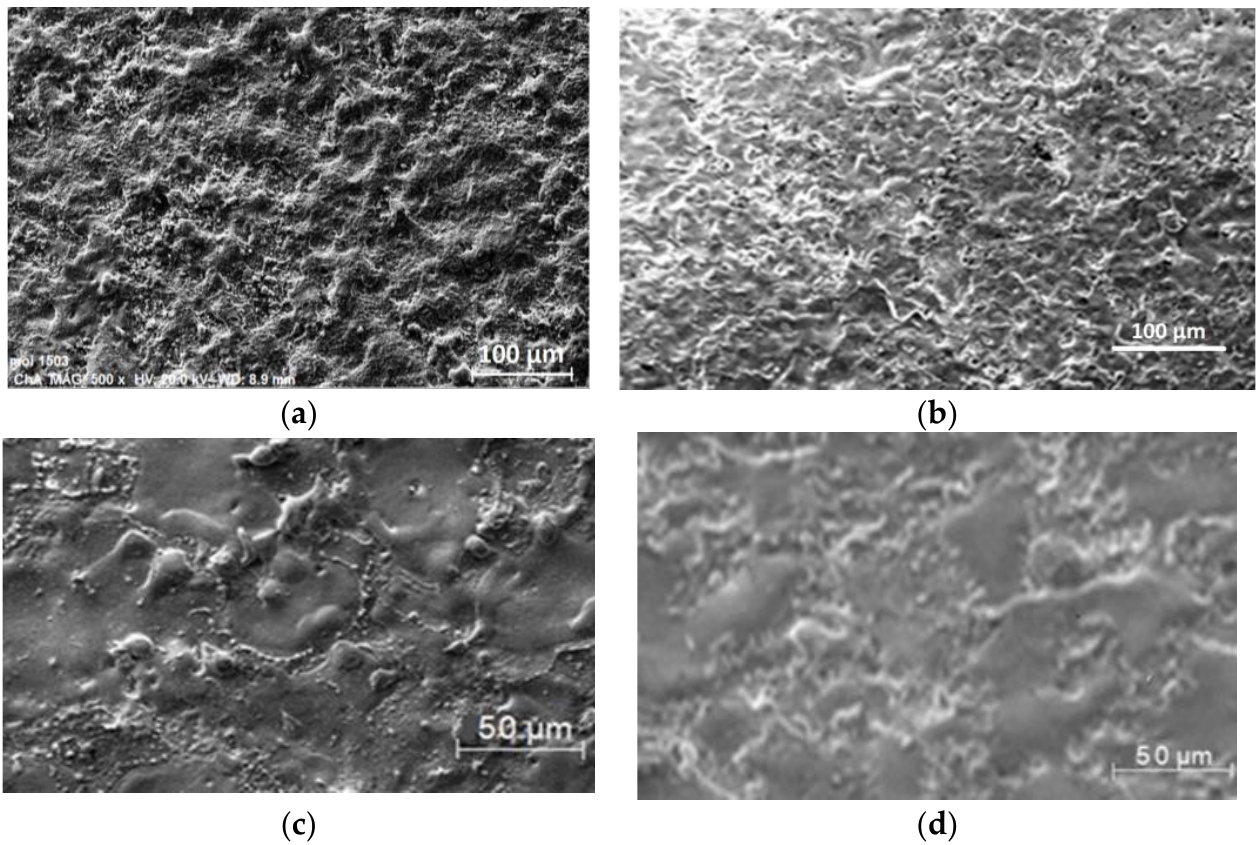
Figure 2. The SEM topography of ESD coated titanium (Ti6Al4V) surface with different electrodes. ( a ) ESD with KW10T10B10 electrode, E = 0.07 J; ( b ) ESD with TiB 2 –TiAl nano electrode, E = 0.07 J; ( c ) ESD with KW10T10B10 electrode, E = 0.04 J; ( d ) ESD with TiB 2 –TiAl nano electrode, E = 0.04 J.